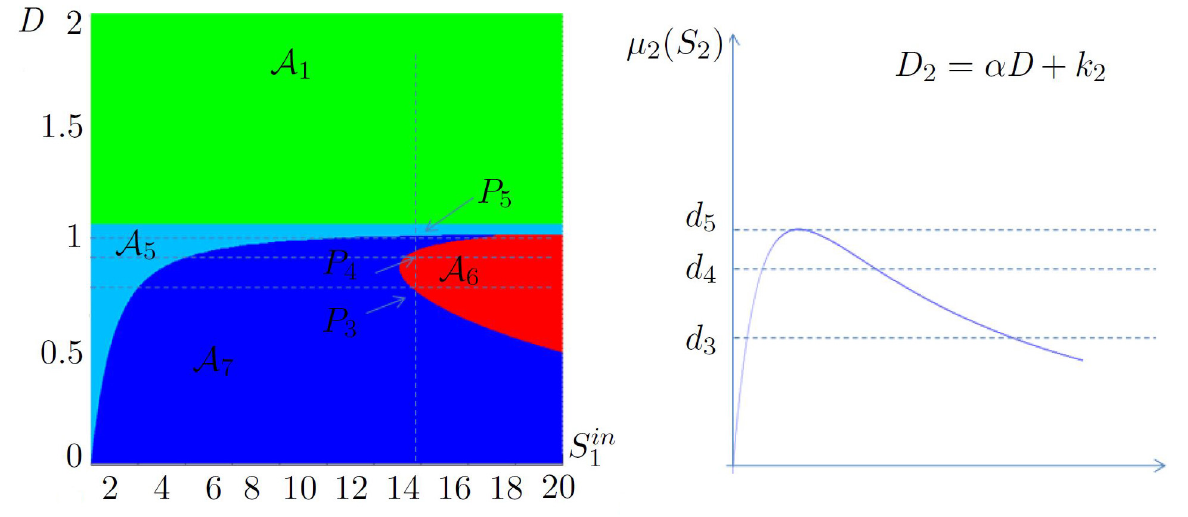
Figure 9. Biological interpretation for S in